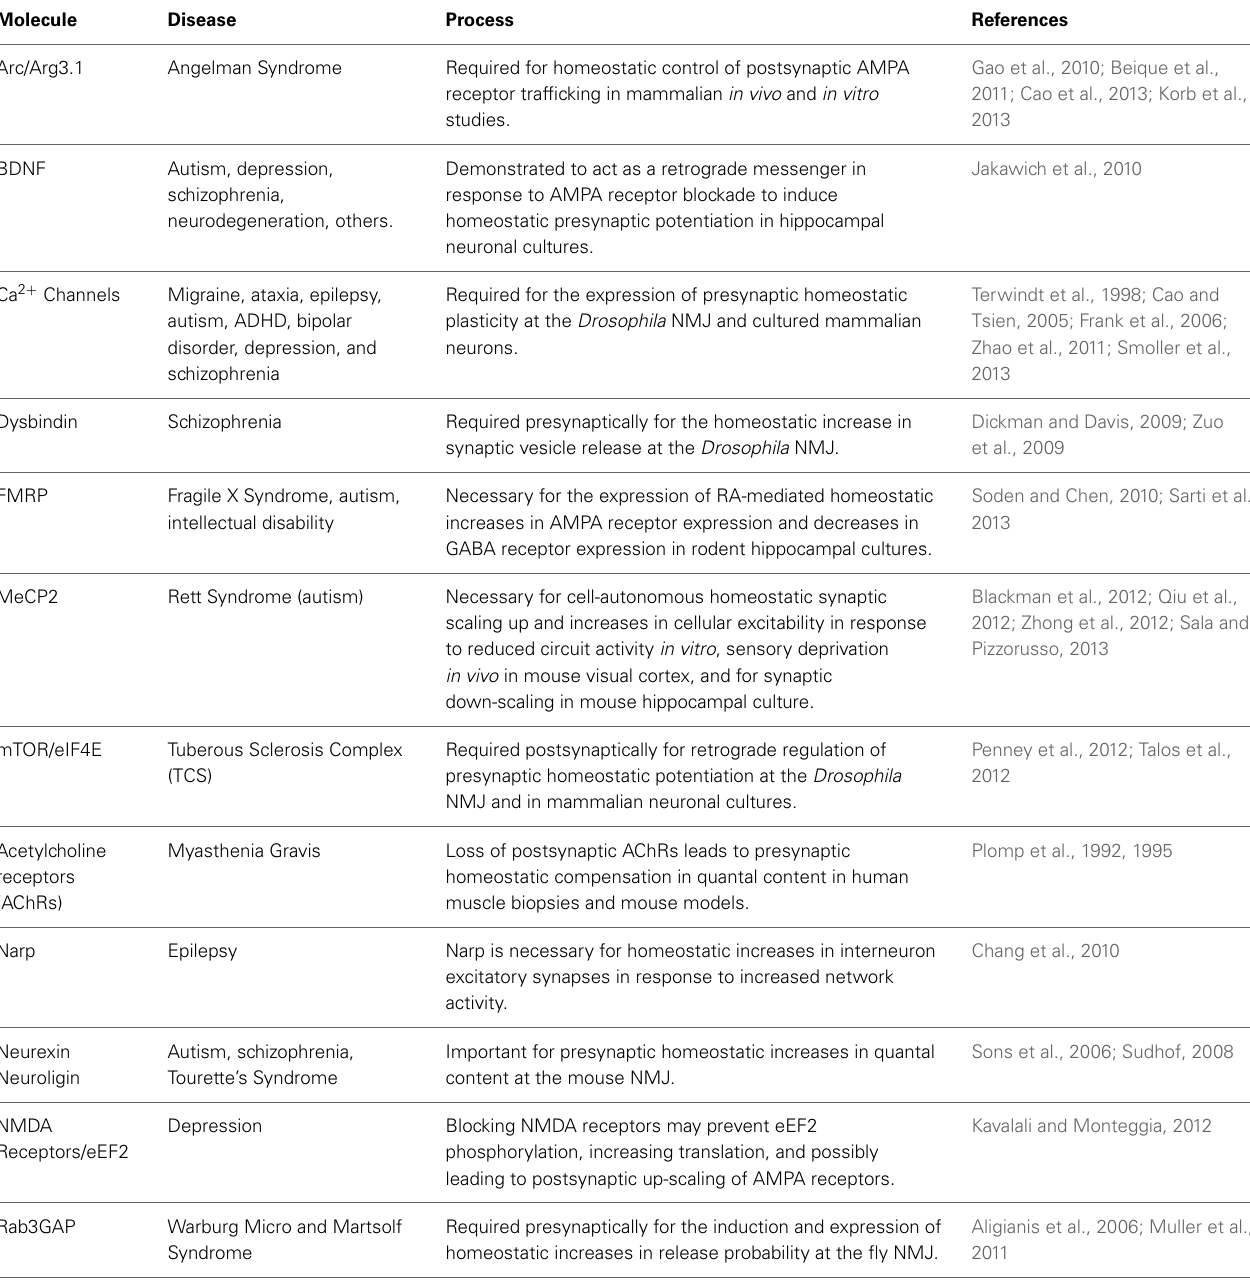
Table 1 | Genes and molecules required for homeostatic synaptic plasticity and linked with neurological diseases.